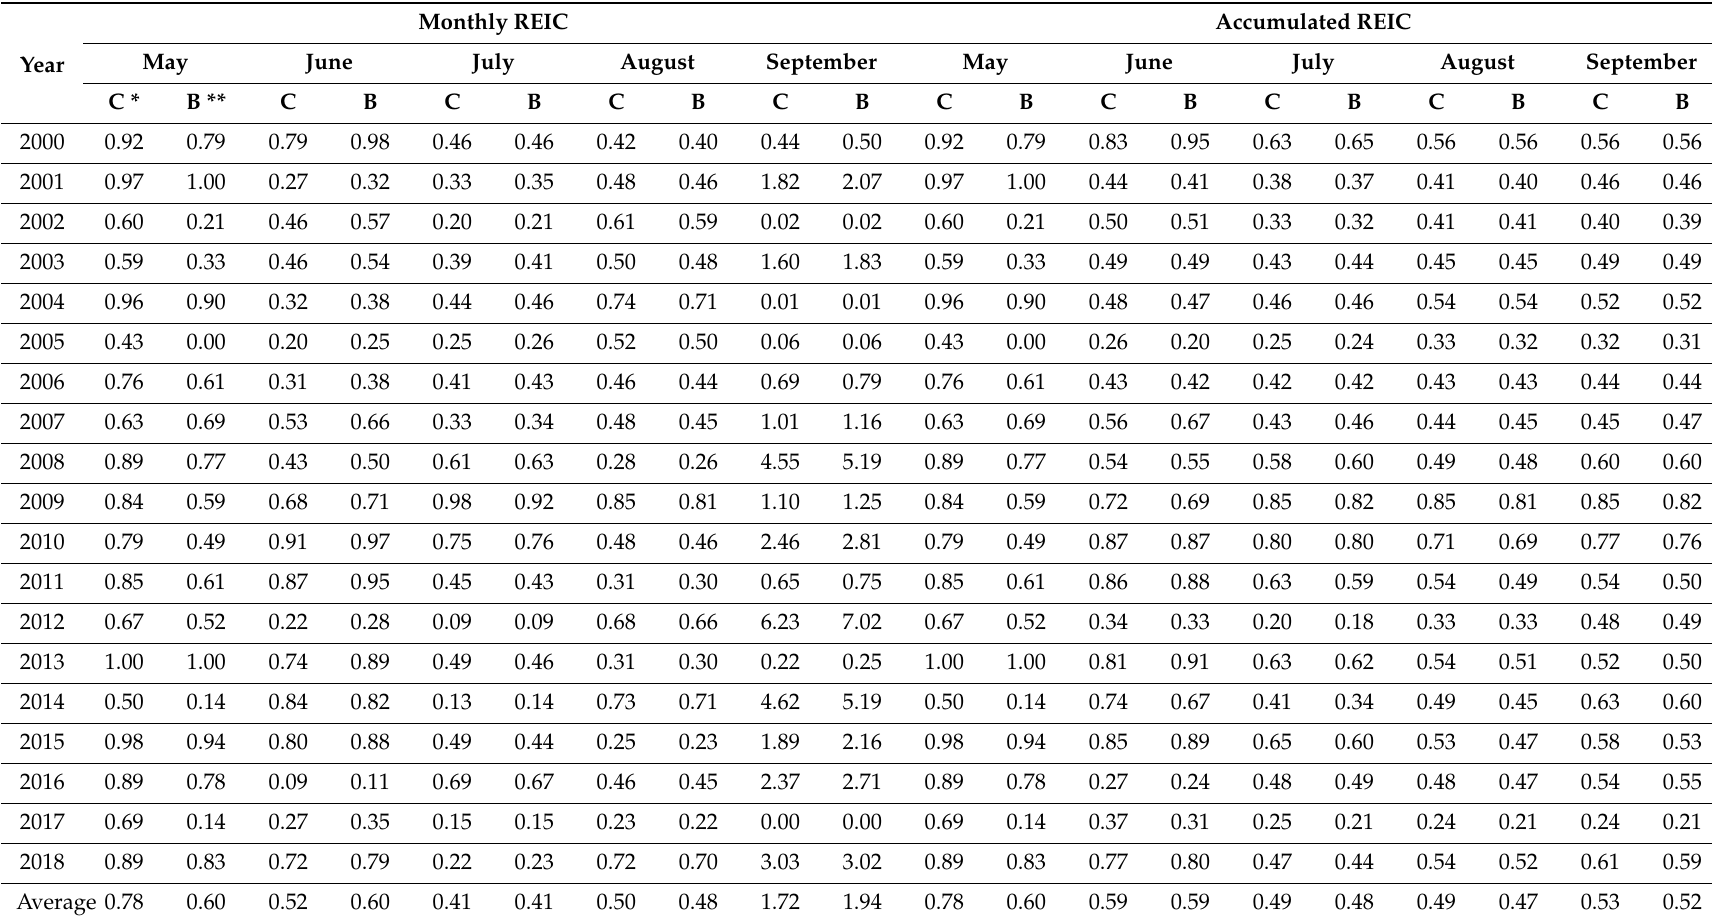
Table 4. Results of monthly REIC and accumulated REIC in Illinois,